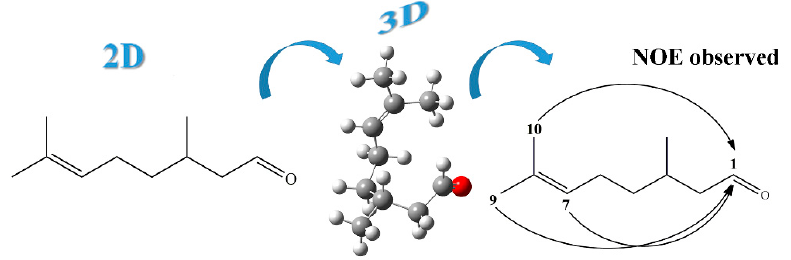
Figure 3. The most stable citronellal conformation and the experimentally observed nuclear Overhauser effect (NOE) interaction.